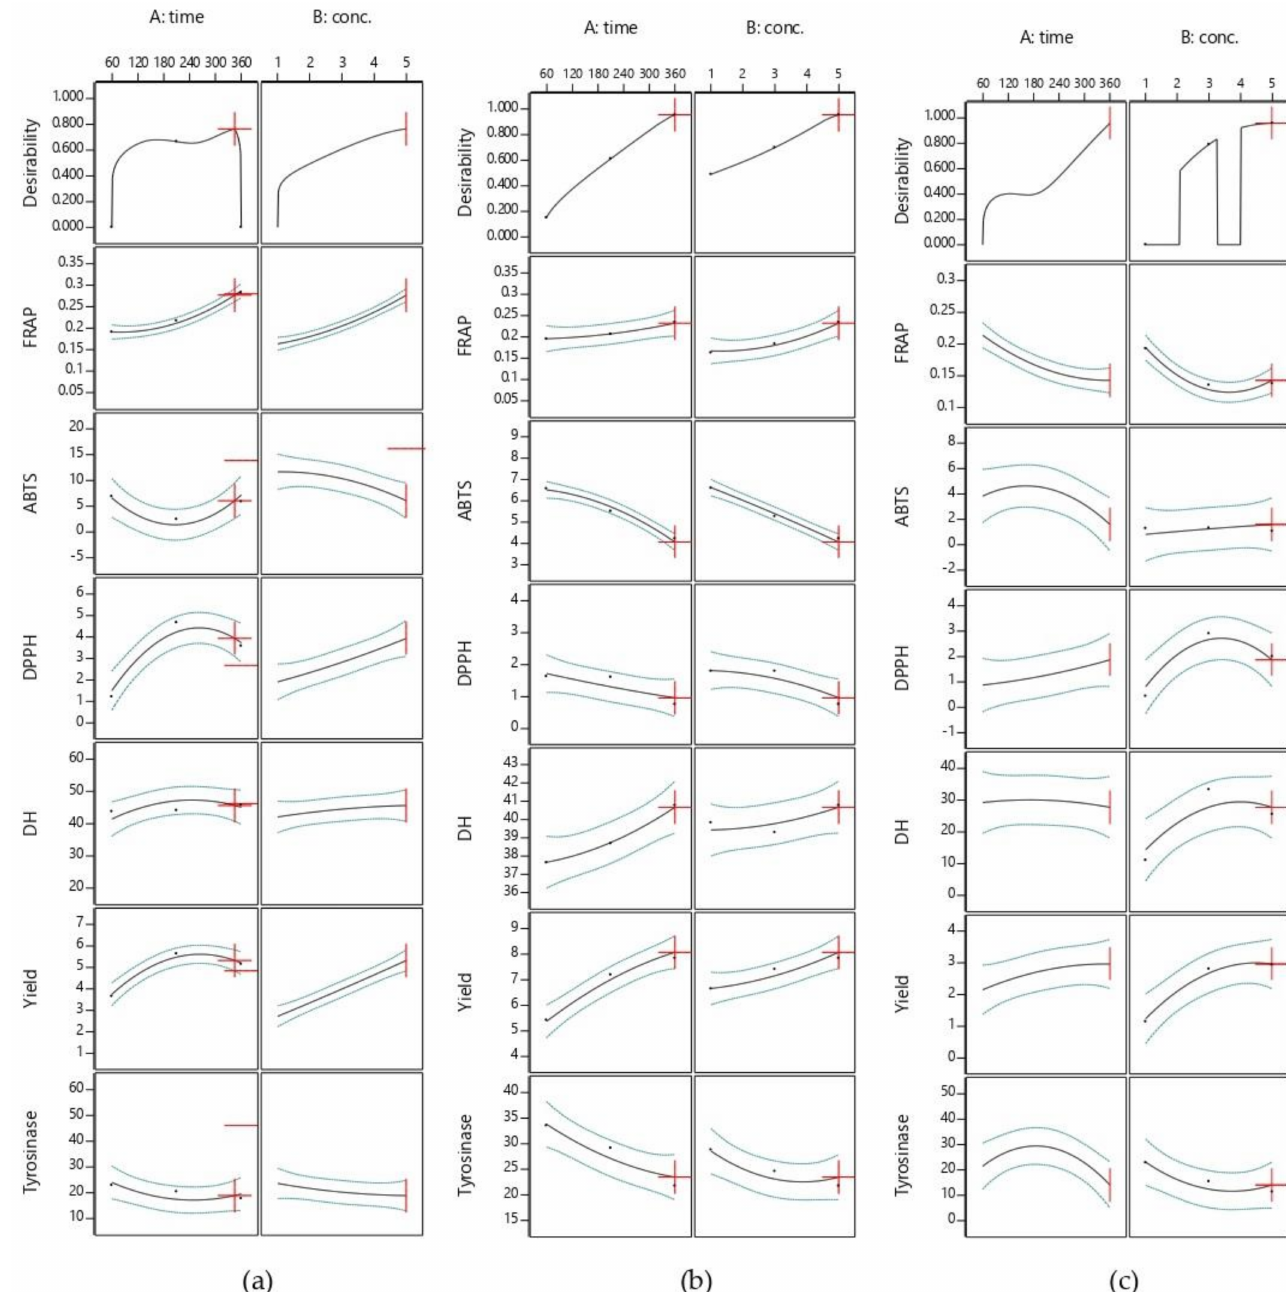
Figure 2. Plots of the main effects of hydrolysis time (X 1 ) and enzyme concentration (X 2 ) on DH, yield, DPPH and ABTS radical scavenging, FRAP value, and tyrosinase inhibition activity using alcalase ( a ), flavourzyme ( b ) and papain ( c )